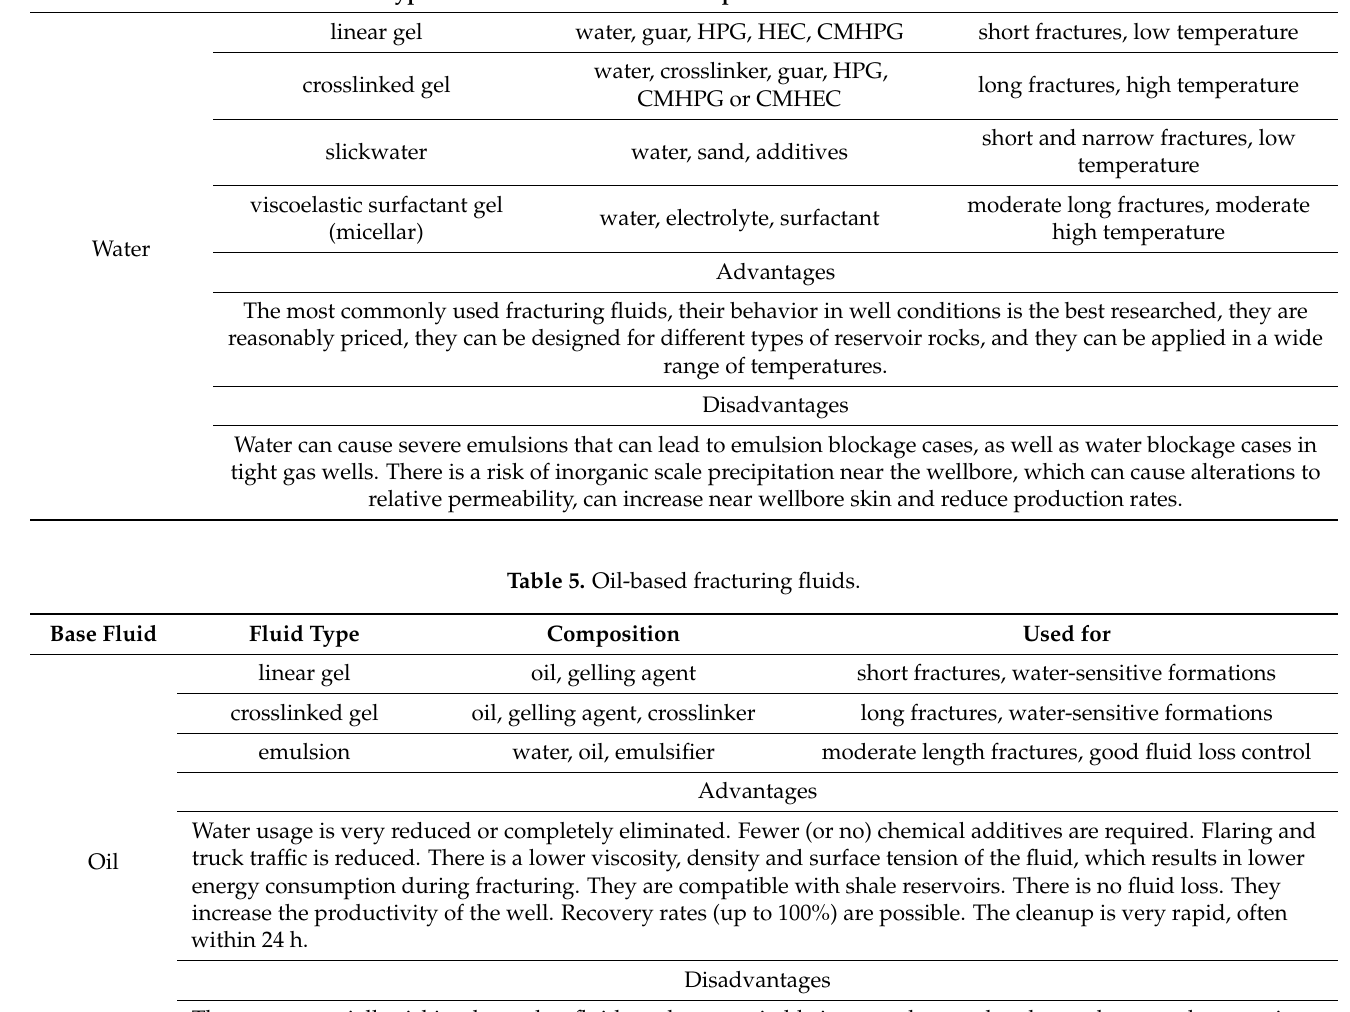
Table 4. Water-based fracturing fluids. HPG: hydroxypropyl guar; HEC: hydroxyethyl cellulose; CMHPG: carboxymethyl hydroxypropy1 guar; CMHEC: carboxymethyl hydroxyethyl cellulose. Base Fluid